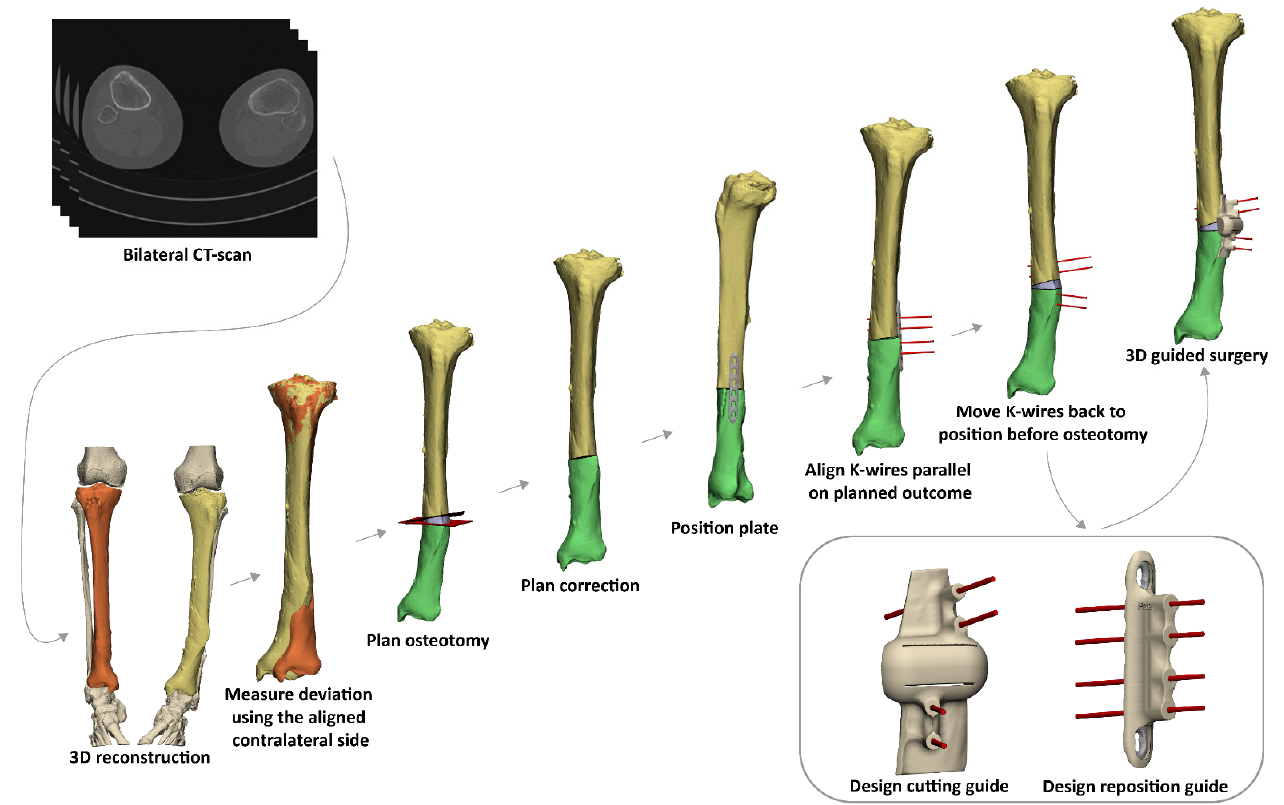
Figure 1. Workflow of a 3D-guided patient-specific corrective osteotomy using a two-step approach. (1) First, a 3D reconstruction is made from a bilateral CT scan. (2) By mirroring and aligning the contralateral (healthy) side on the malunited bone (orange), the deviation is measured. (3) Based on the deviation, the osteotomy and the correction are planned. (4) An osteosynthesis plate is chosen and positioned on the bone after correction. (5) K-wires are positioned parallel on the planned correction. (6) K-wires are placed parallel on the corrected bone, duplicated and moved to the corresponding position on the malunited bone before the correction is performed. (7) Patient-specific cutting and reposition guides are designed. (8) 3D-guided osteotomy is performed using the patient-specific cutting guide. Subsequently, the cutting guide is removed and the reposition guide (including the plate) is slid over the K-wires to achieve the intended correction.